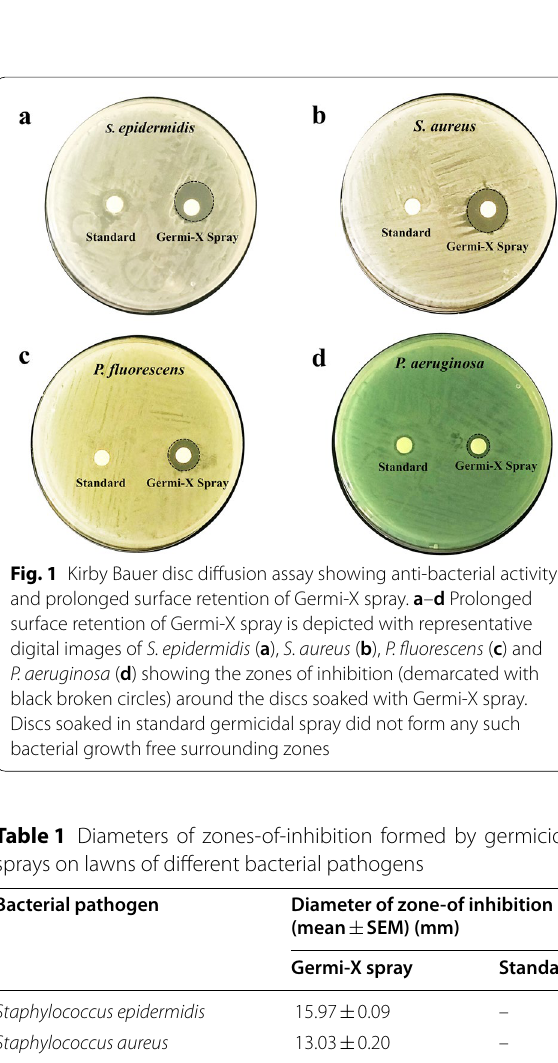
lawns, whereas, discs soaked with Germi-X spray developed distinct bacteria-free clear circular zones around themselves over all the bacterial lawns. These clear zones were formed due to removal of bacteria from those areas. Their appearances around the Germi- X-soaked discs implies that Germi-X spray was capa- ble of eliminating bacteria around itself. The diameters of the zones-of inhibition give a relative idea of the extent of ensuing bacterial elimination from the zone.